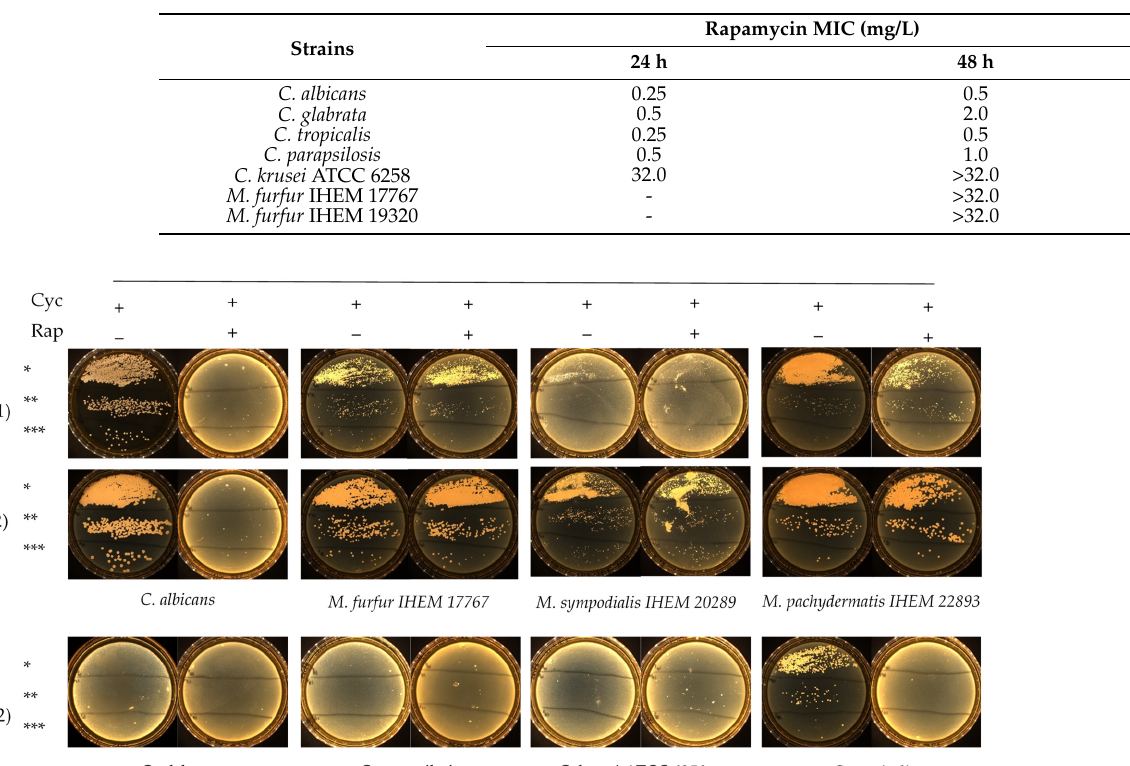
Table 1. Rapamycin in vitro susceptibility testing against M. furfur and Candida spp.